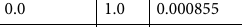
CMC (%) n K (Ns n /m 2